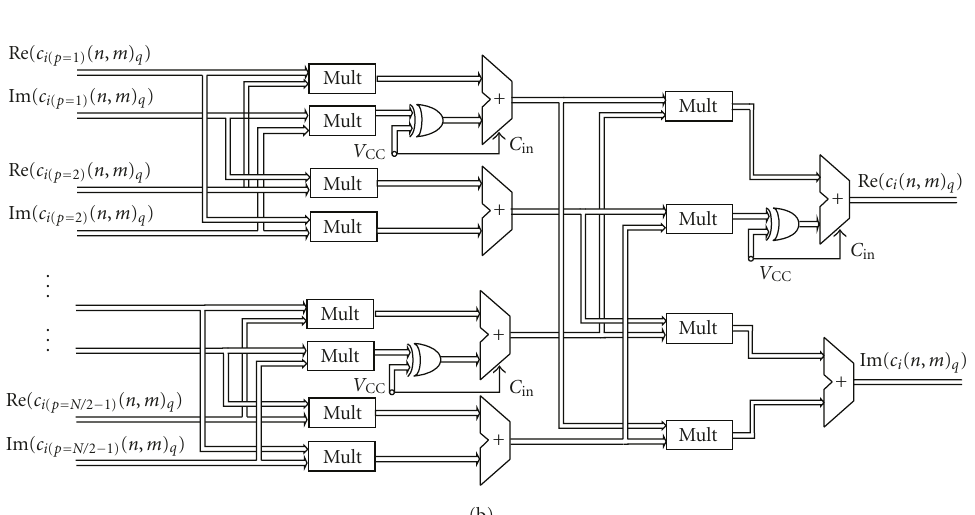
and (b) c i ( n , m ) q q